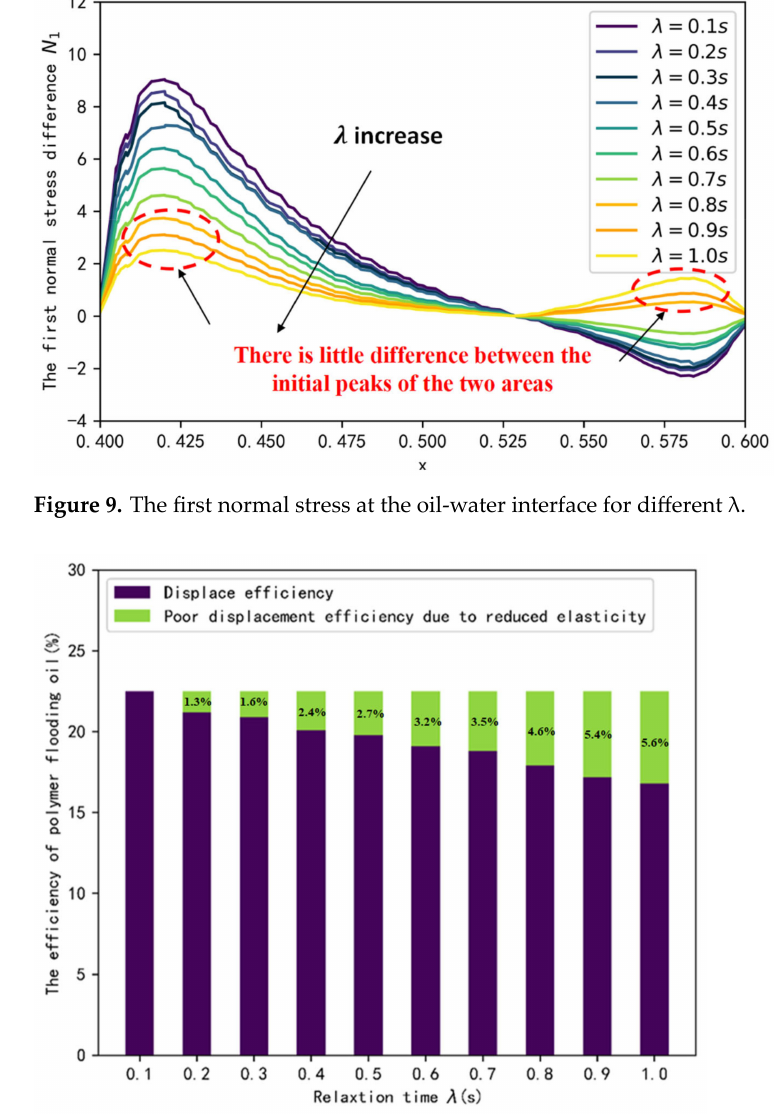
Figure 10. The displacement efficiency for different λ